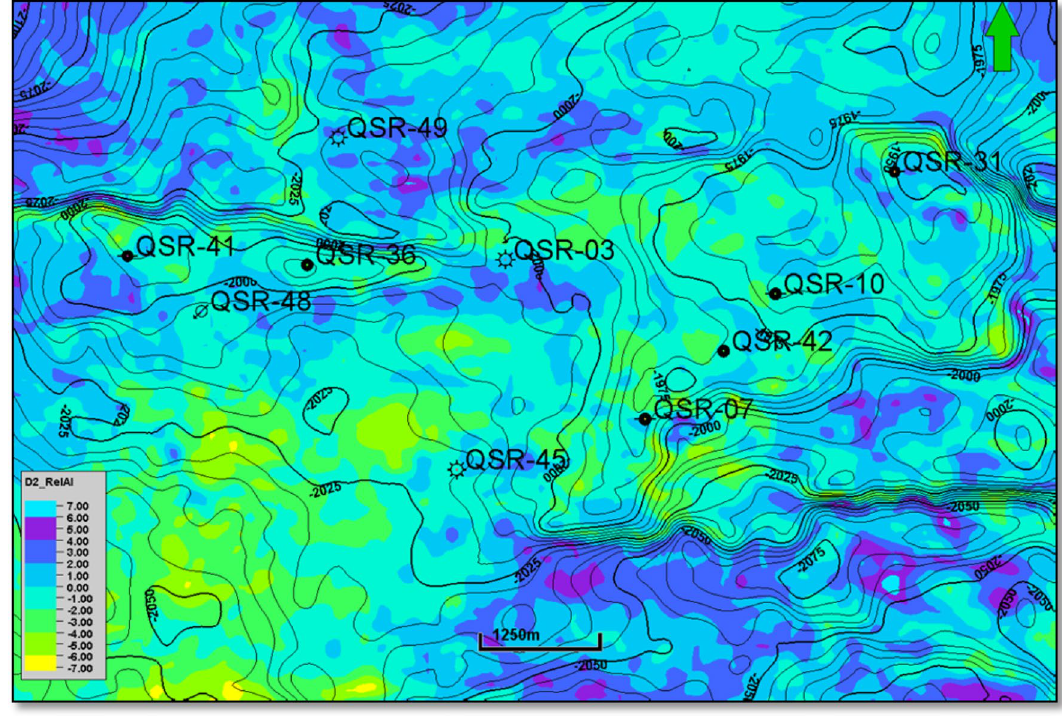
Fig. 19 Relative AI map for unit AEB-3D (D2). The map is overlain by black depth structure contour lines